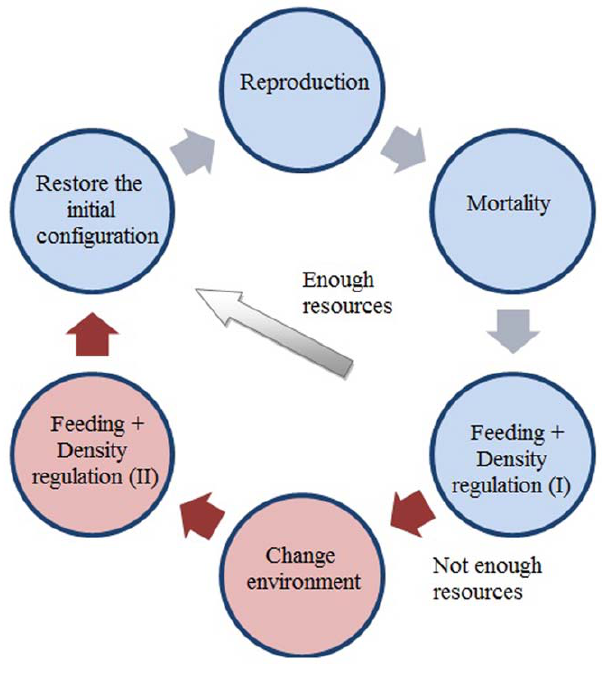
Figure 5. Sequence of the different modules that make up the model. The execution of a loop is equivalent to the passage of one year in the ecosystem.